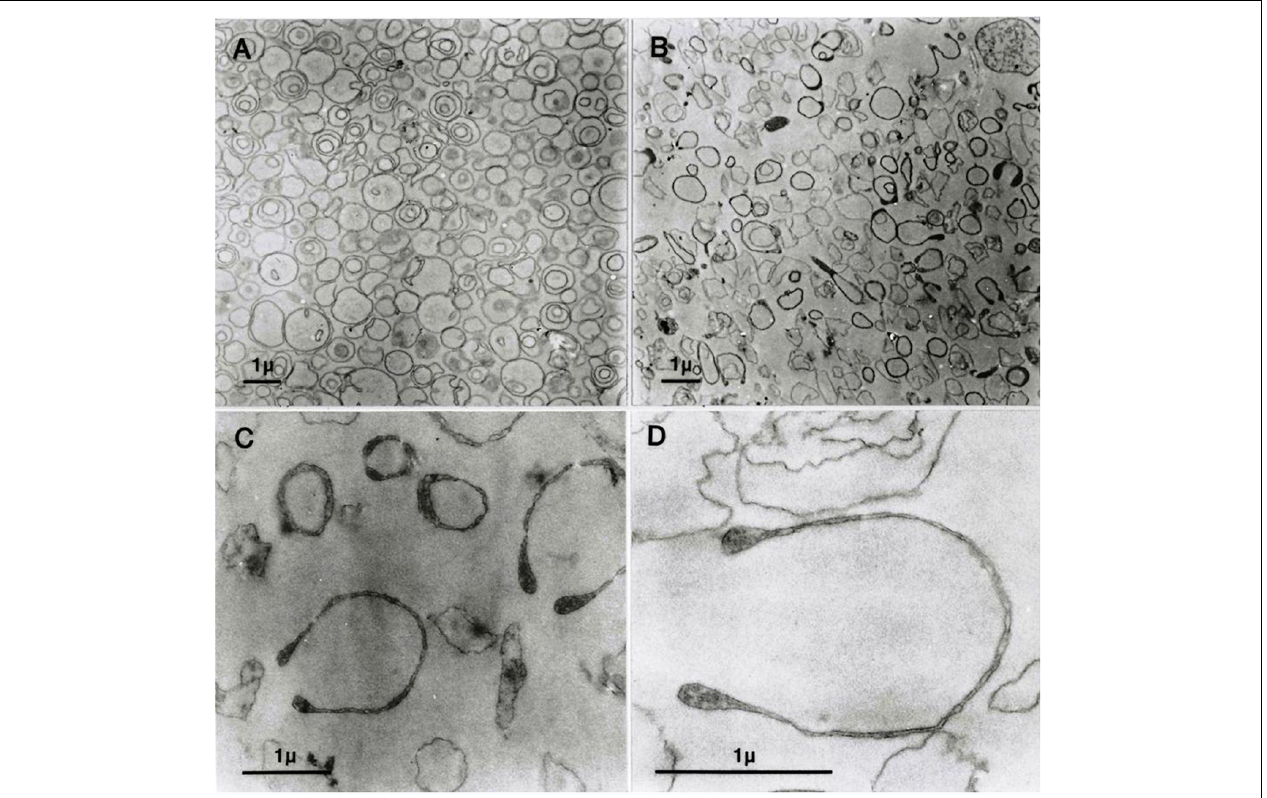
FIGURE 1 | Transmission electron micrographs (EMs) of predominantly inside–out vesicles obtained by the one-step method (Lew et al., 1982; Garcia-Sancho and Alvarez, 1989). (A) Aliquots of the vesicle suspension after incubation in lysis medium A at 37 ◦ C were treated and further processed for EM as outlined in Section “Materials and Methods”. (B–D) Vesicles in aliquots of the suspension described for panel A were spun, washed, and resuspended in medium B, processed for EM, and observed at increasing magnifications in (C,D)